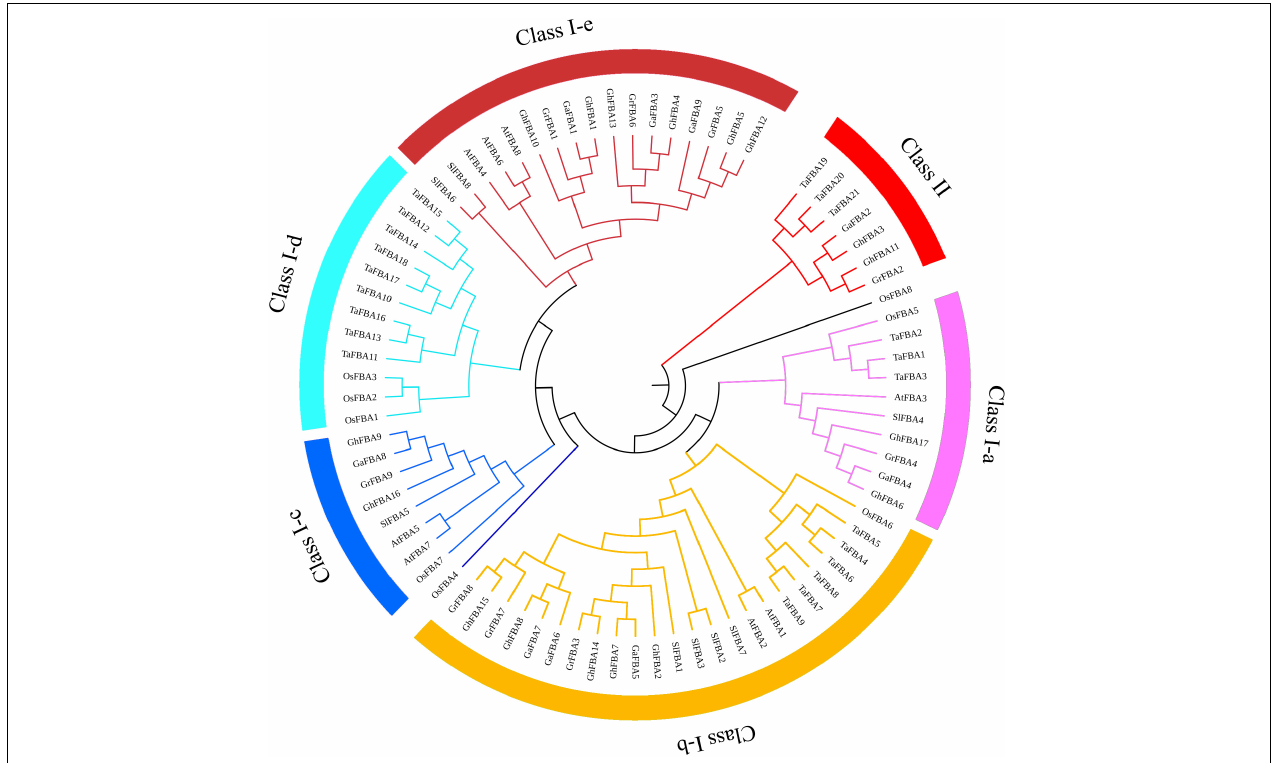
FIGURE 2 | An unrooted phylogenetic tree representing relationships among FBA proteins from G. hirsutum (Gh) , G. arboreum (Ga) , G. raimondii (Gr) , A. thaliana (At) , T. aestivum (Ta), O. sativa (Os) and S. lycopersicum (Sl) . The different colors arcs indicate different classes or subclasses. Clustal W was used to align the sequences, MEGA7.0 was used to construct phylogenetic trees with neighbor-joining method.